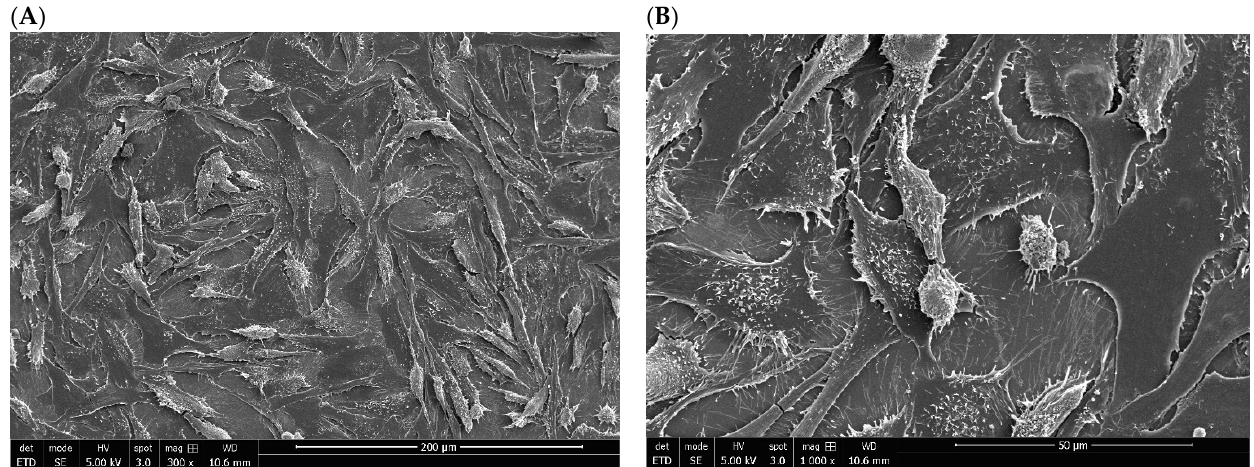
Figure 4. SEM image of SaOs-2 bone cells seeded on the surface of S_TiCp (mirror polished) disc at initial magnification of 300× ( A ) and 1000× ( B ) after a 72-h-incubation period. On the mirror-polished surface of S_TiNb discs, cultured SaOs-2 cells also displayed a random orientation and formed a nearly confluent layer. However, pseudopodia are less individualized, which could be due most likely to a less efficient gold sputtering met- allization process (Figure 5A,B). ( A ) ( B ) Figure 5. SEM image of SaOs-2 bone cells seeded on the surface of S_TiNb (mirror polished) disc at initial magnification of 300× ( A ) and 1000× ( B ) after a 72-h incubation period. 3.5. Influence of Increasing Doses of KNbO 3 on THP-1 Cell Metabolic Activity Because little information is available about the immunotoxicity of dissolved nio- bium KNbO 3 , we exposed THP-1 monocytes to increasing concentrations of KNbO 3 salt solution. Metabolic activity was examined after a 24 h period of incubation by measuring mitochondrial dehydrogenase activity using WST-1 assay. KNbO 3 had no significant ef- fect on the growth profile of THP-1 cells compared to the control group no matter the concentration (Figure 6). An hormesis effect, although not significant at the statistical level, was noticed when THP-1 monocytes were exposed to 3 to 50 µg/mL of potassium niobate. Therefore, we defined 25 µg/mL as an experimental dose for transcriptomic pro- filing.